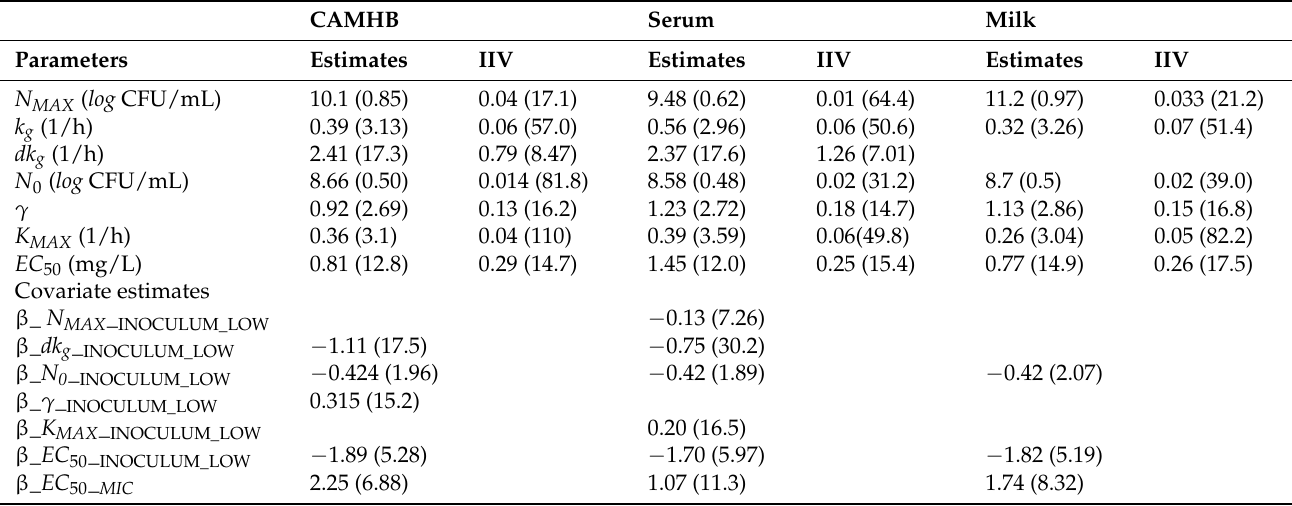
Table 2. Final parameters from one population bacterial model for each growth medium used. Data presented as estimates with % RSE, including inter-individual variability (IIV).